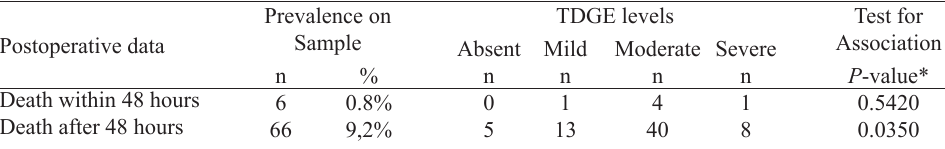
Table 6. The occurrence of death within 48 hours and after 48 hours after